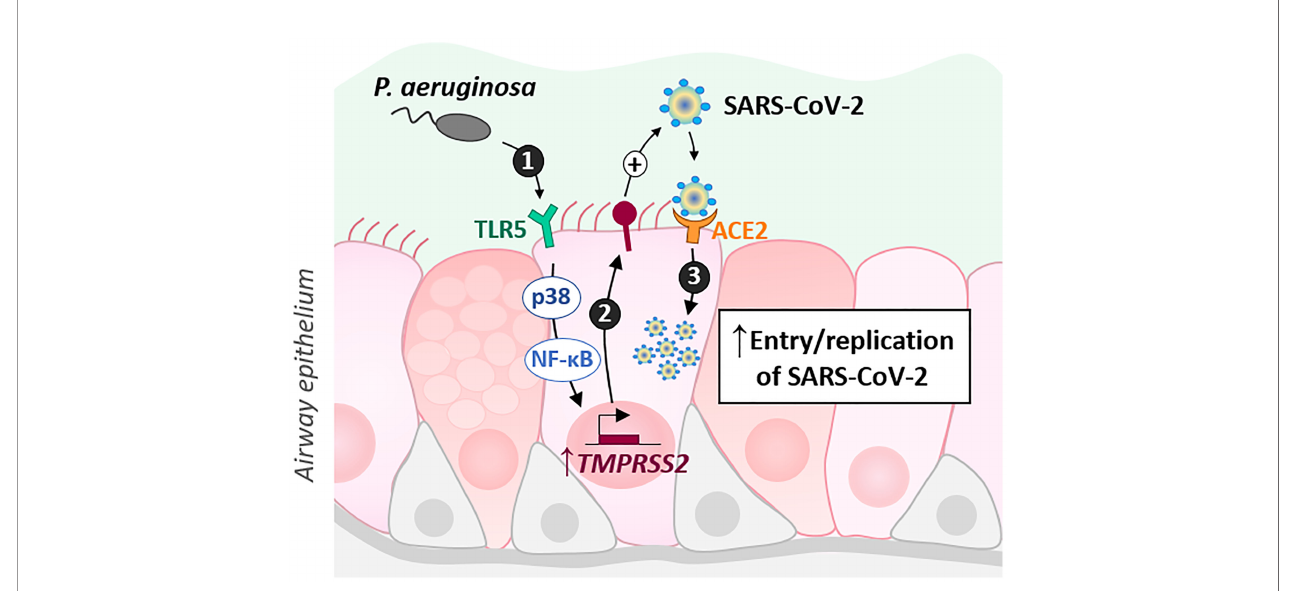
FIGURE 5 | Schematic illustrating the results. P. aeruginosa interacts with the airway epithelial cells of pwCF, notably by activating the TLR5 signaling pathway through its virulence factor, fl agellin. This activation, dependent on p38 MAPK and NF-kB, leads to an increase in TMPRSS2 which could regulate SARS-CoV-2